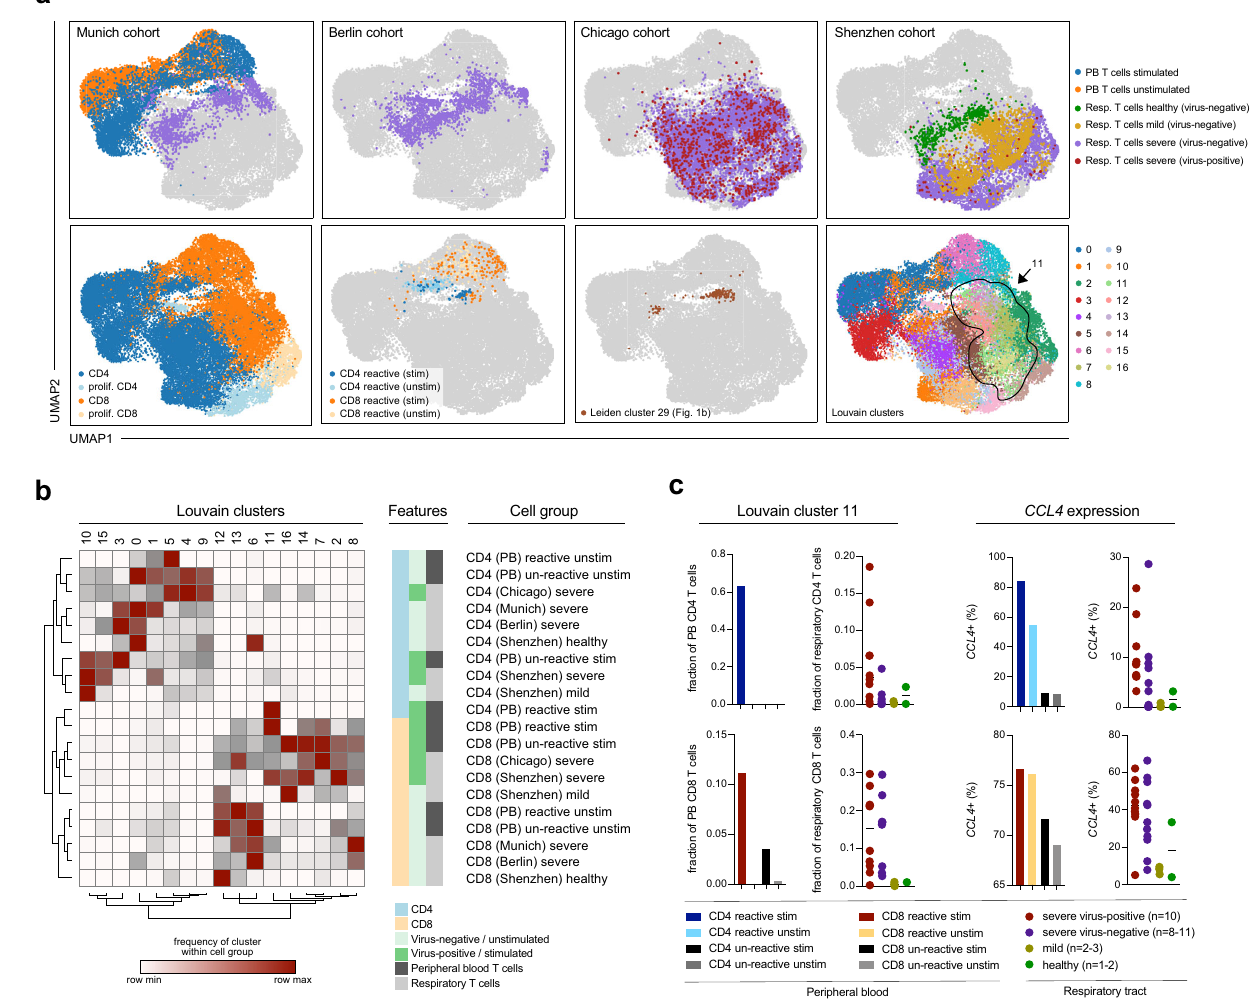
Fig. 4 Phenotypic convergence of in vitro stimulated reactive T cells from peripheral blood and ex vivo T cells from the respiratory tract of severely diseased patients. a Top panels: UMAPs of previously analyzed peripheral blood (PB) T cells and T cells from tracheal aspirates (TA) of the same (patient GT_3) and additional patients with severe disease (Munich cohort) as well as from bronchoalveolar lavage fl uid (BALF) from patients with mild disease, severe disease and healthy donors (Chua et al. 47 — Berlin cohort; Grant et al. 49 — Chicago cohort; Liao et al. 48 — Shenzhen cohort); bottom panels (from left to right): CD4 or CD8 (proliferating or not) cell types, reactive PB T cells from stimulated or unstimulated conditions (see previous fi gures), IFNG-positive antigen- “ reactive ” Leiden cluster 29 cells (see Fig. 1b), Louvain clusters ( n = 30,033 T cells from 28 patients). b Hierarchical clustering of cell types and Louvain clusters based on “ one minus Pearson ” correlations of deviations from baseline compositions for each cell type across Louvain clusters. PB, peripheral blood T cells. Cohort names (Munich, Chicago, Berlin, Shenzhen) refer to respiratory tract T cells. Fractions of CD4 or CD8 T cells in PBMCs or respiratory materials (Supplementary Fig. 12) served as input compositions. c Fractions of Louvain cluster 11 or CCL4 expressing cells among (from left to right and top to bottom) PB CD4 T cells, respiratory CD4 T cells, PB CD8 T cells, or respiratory CD8 T cells. For respiratory T cells, data for individual patients with indicated disease stages are shown (represented by dots; n = 2 healthy, n = 3 mild, n = 11 severe-cold, n = 10 severe-hot; patients with <20 cells in Louvain cluster 11 were excluded from